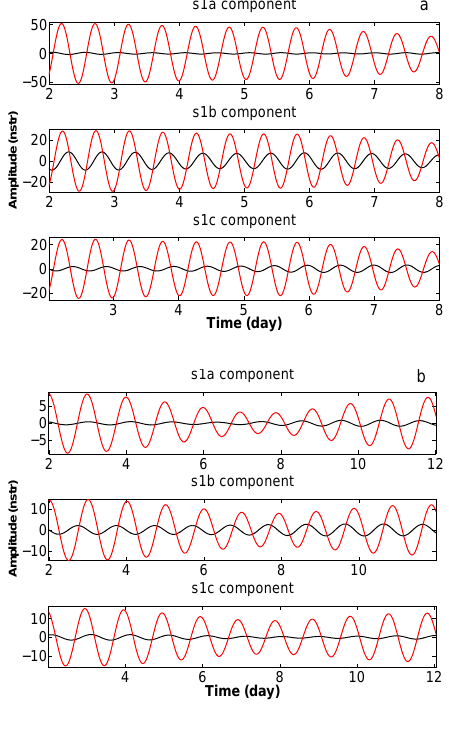
Figure 12. (a) 6 days of residual strain signals during june 2010 (black curves) and observed strain signal (red curves) fil- tered in 10-14h frequency band. (b) 10 days of residual strain signals during june 2010 (black curves) and ob- served strain signal (red curves) filtered in 22-26h fre- quency band.